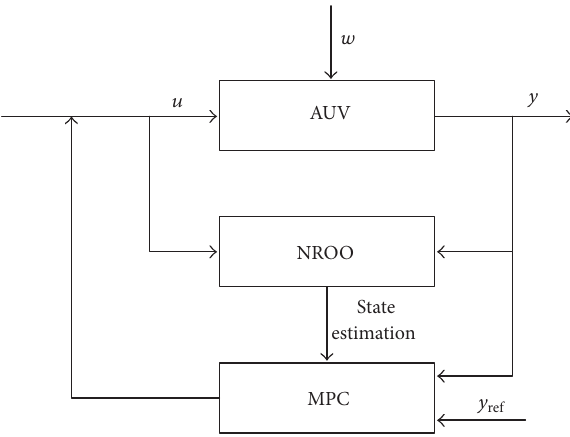
Figure 1: Block diagram of the proposed